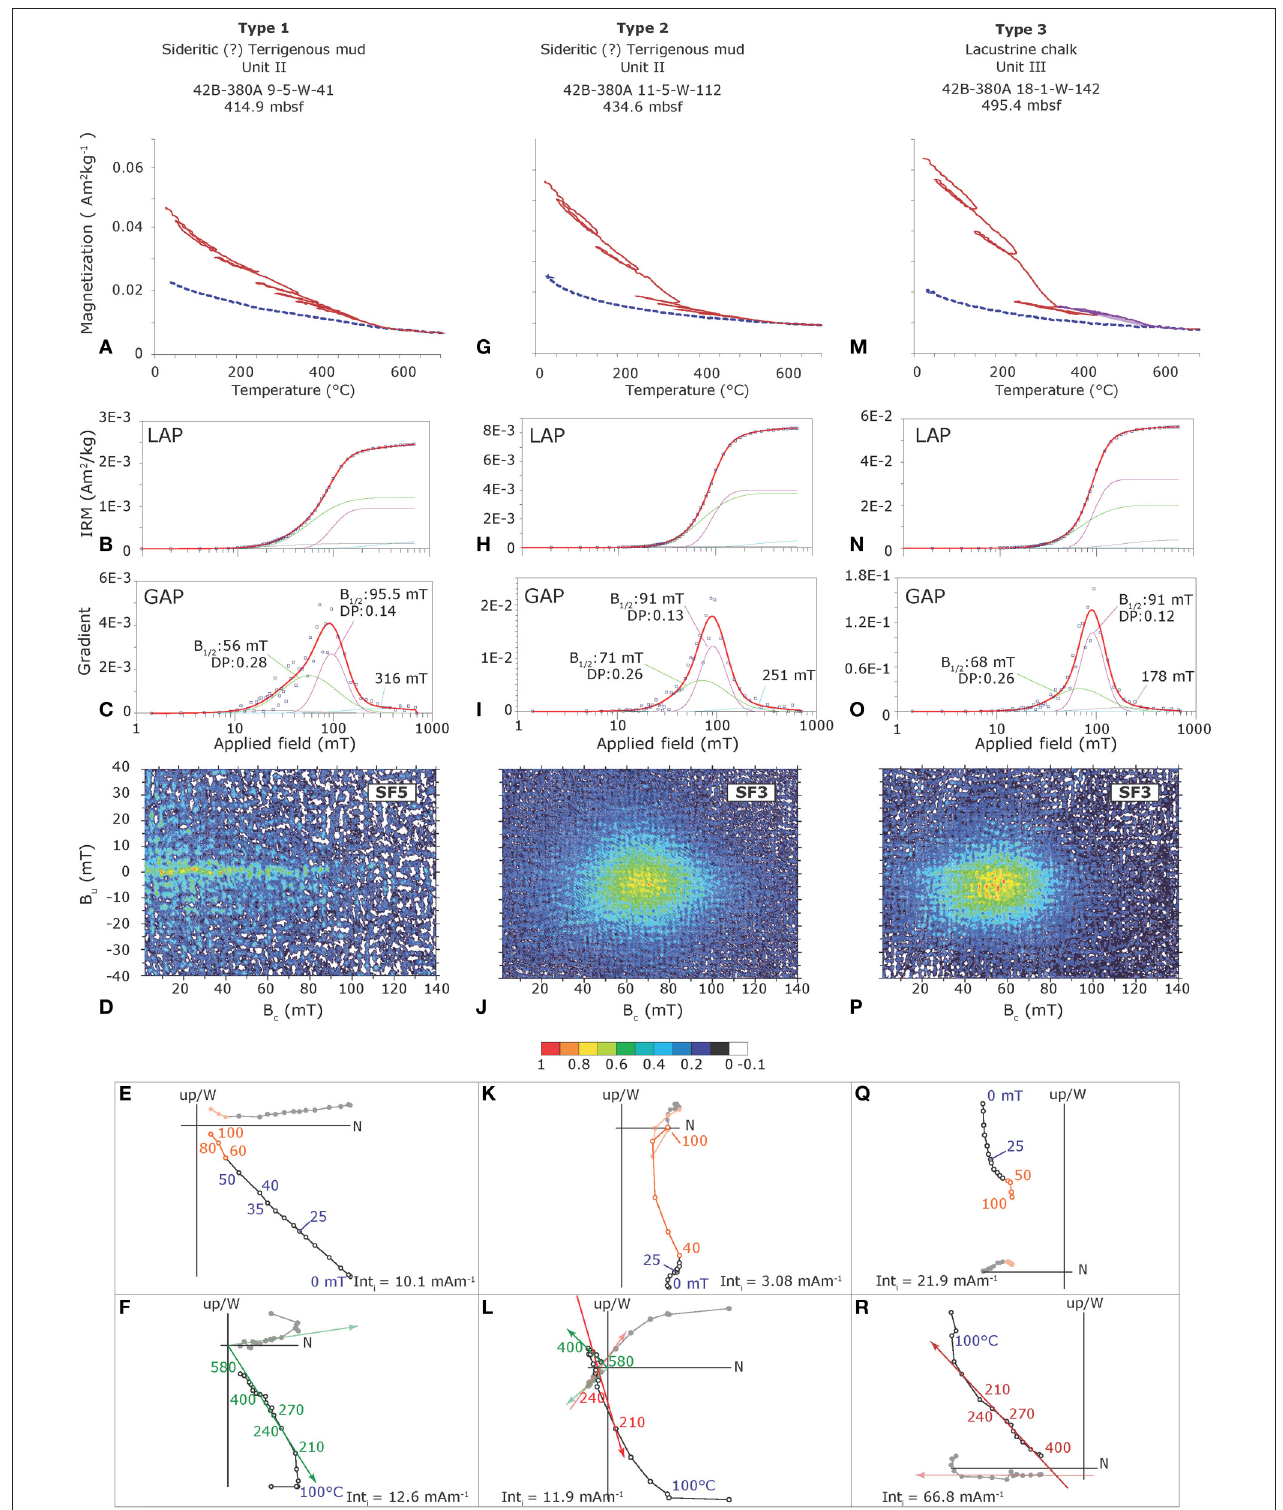
FIGURE 2 | Rock-magnetic properties and demagnetization diagrams for Types 1–3. From top to bottom: Lithology, lithological unit, core (expedition-site-core-section-half (W = working)-interval), depth in meters below sea floor (mbsf). (A,G,M) thermomagnetic runs up to 700 ◦ C, in red heating to increasingly higher temperatures, in blue (dashed) cooling back to 20 ◦ C. Purple colors (where present) indicate an increase in magnetization related to the conversion